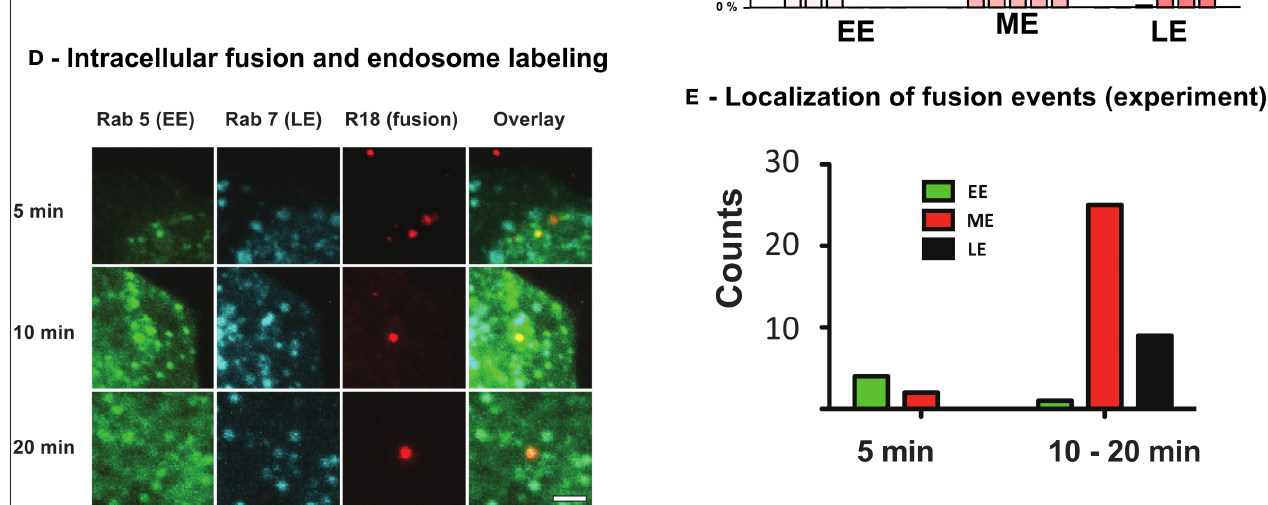
120 among the 400 HAs covering the virus envelope = Na 6. (C) Using time windows of fusion onset ≤ ≤ 1 µ m (E) In vivo localization of fusion events. Fusion events were counted and = Rab7) or LE +